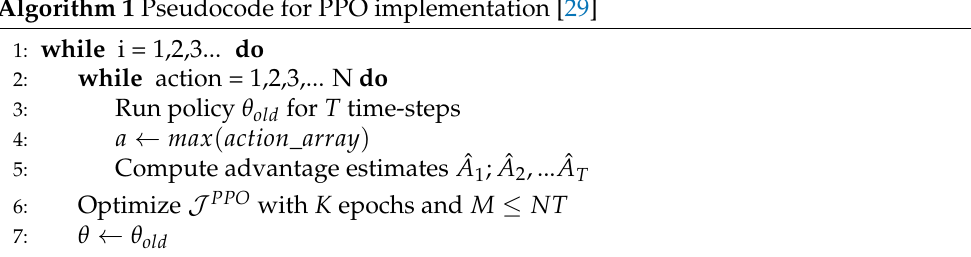
Figure 3. The reinforcement learning architecture based on Proximal Policy Optimization. Algorithm 1 Pseudocode for PPO implementation